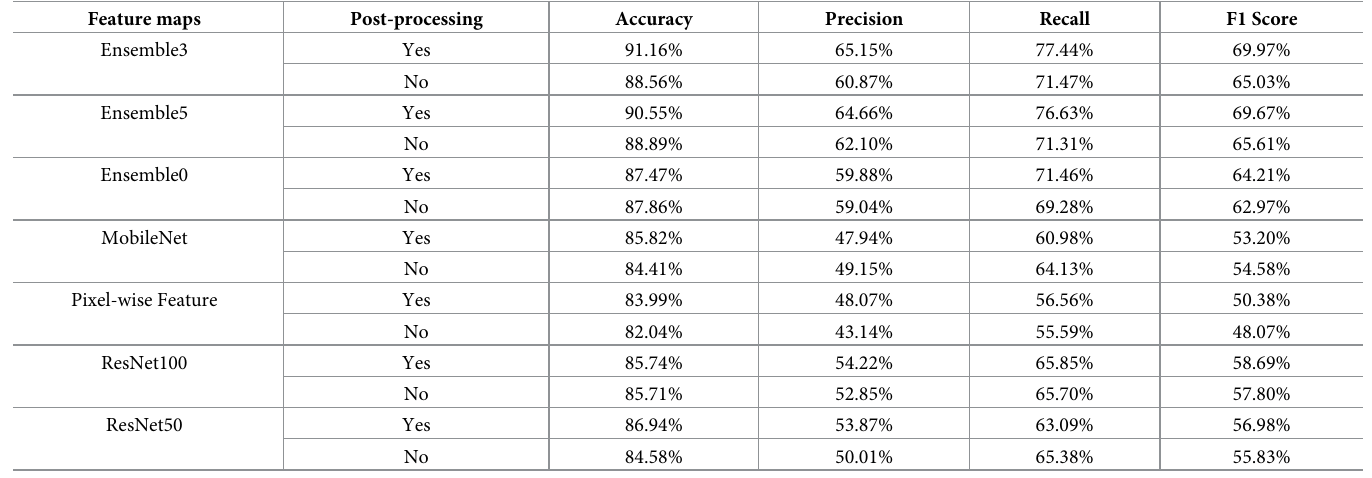
Table 2. Testing the feature maps and input